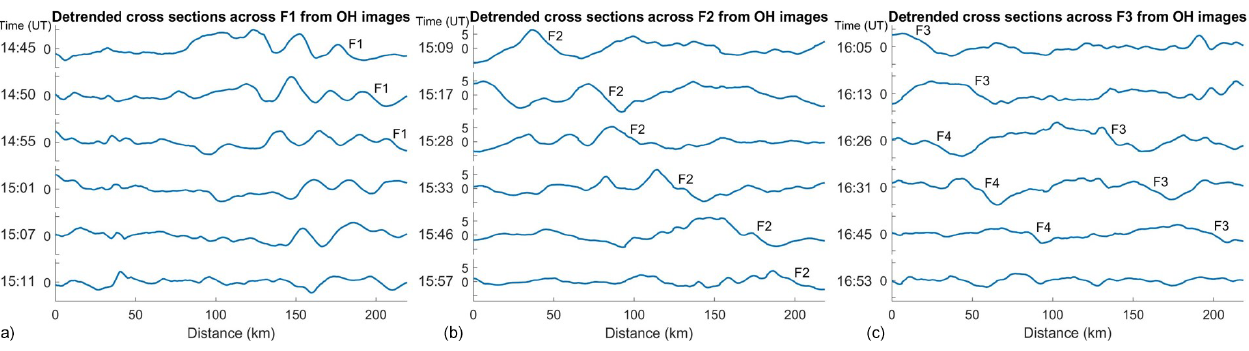
Figure 5. Cross sections extracted and detrended across the fronts from the percentage-differenced OH images. (a) Cross sections across F1, (b) across F2, and (c) across F3 and F4. Table 2. The physical parameters of the observed fronts